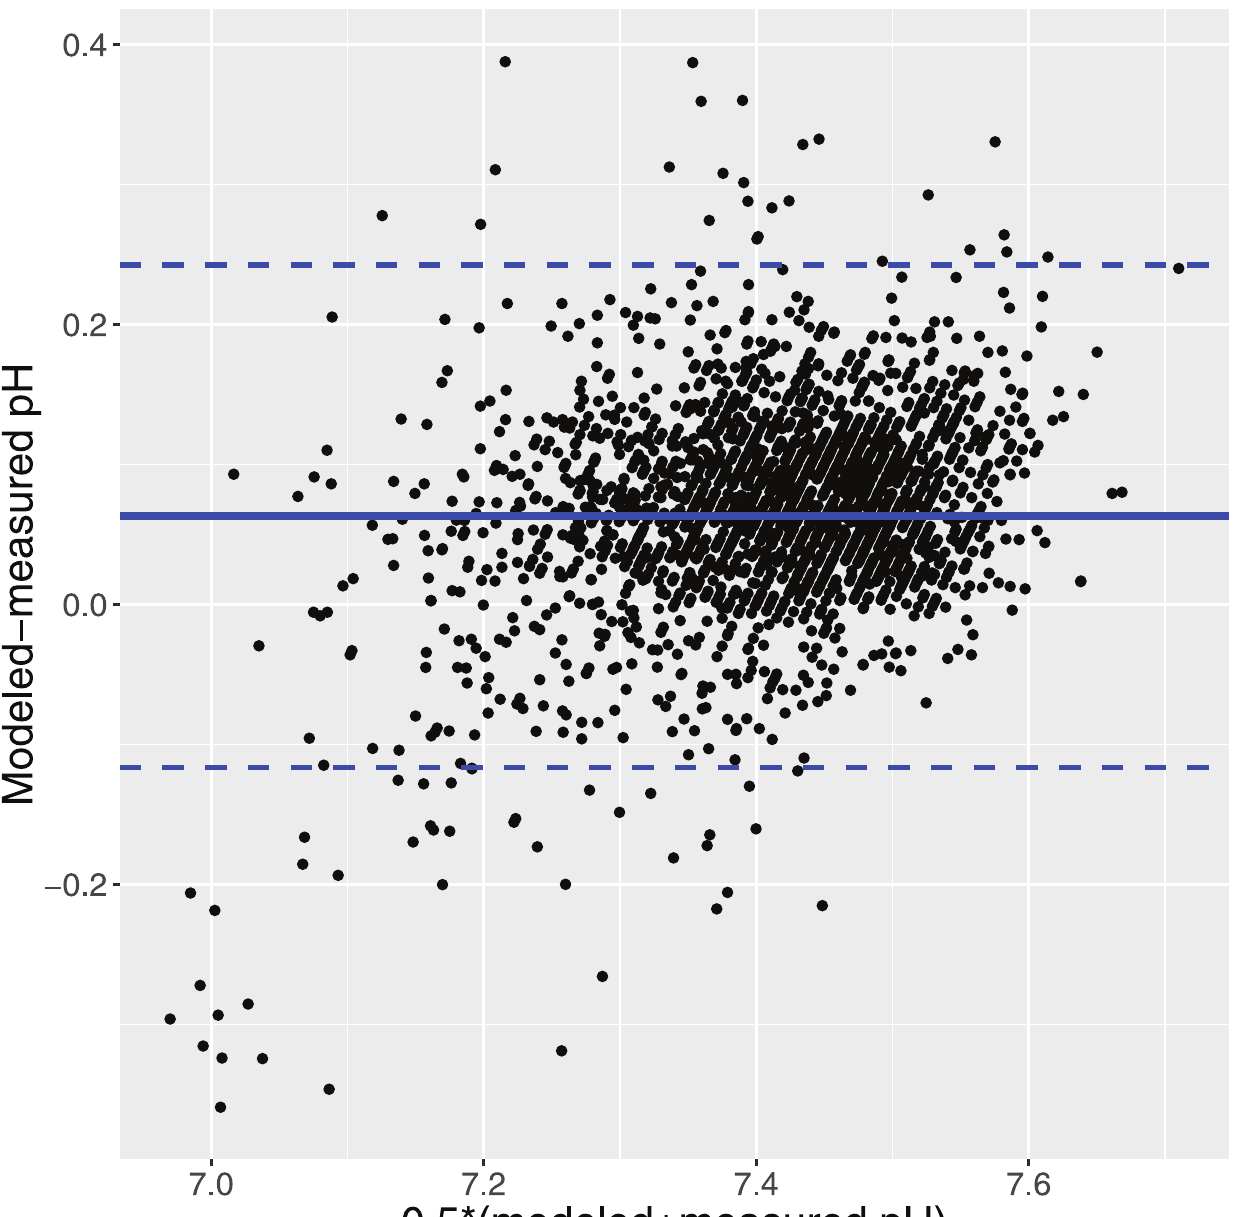
Fig 6. Fig 6 shows a Bland-Altman plot of fitted-measured pH versus mean of fitted and measured pH. The lines indicate mean and 95% confidence